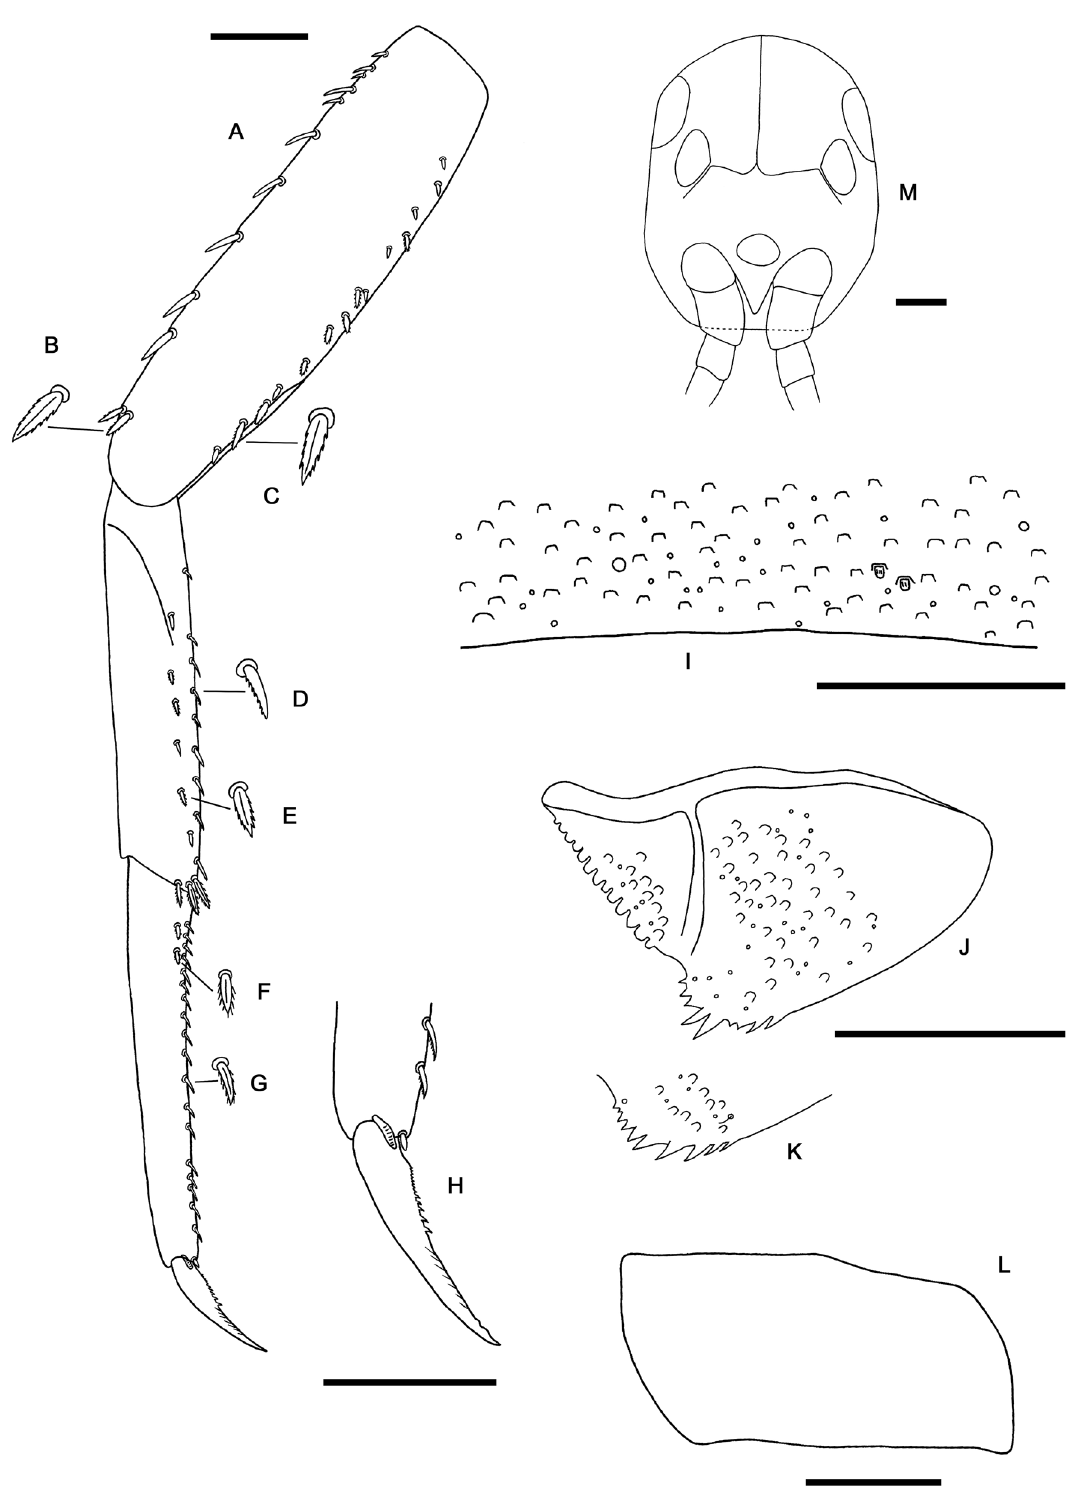
Fig. 6. Procerobaetis petersorum gen. et sp. nov., larval morphology. A . Foreleg. B . Seta on dorsal margin of femur (apex). C . Seta on ventral margin of femur. D . Seta on ventral margin of tibia. E . Seta on ventral surface of tibia. F . Seta near ventral margin of tarsus. G . Seta on ventral margin of tarsus. H . Fore claw. I . Tergum IV. J . Paraproct. K . Paraproct, posterior margin. L . Metanotum. M . Head. Scale bars: 0.1